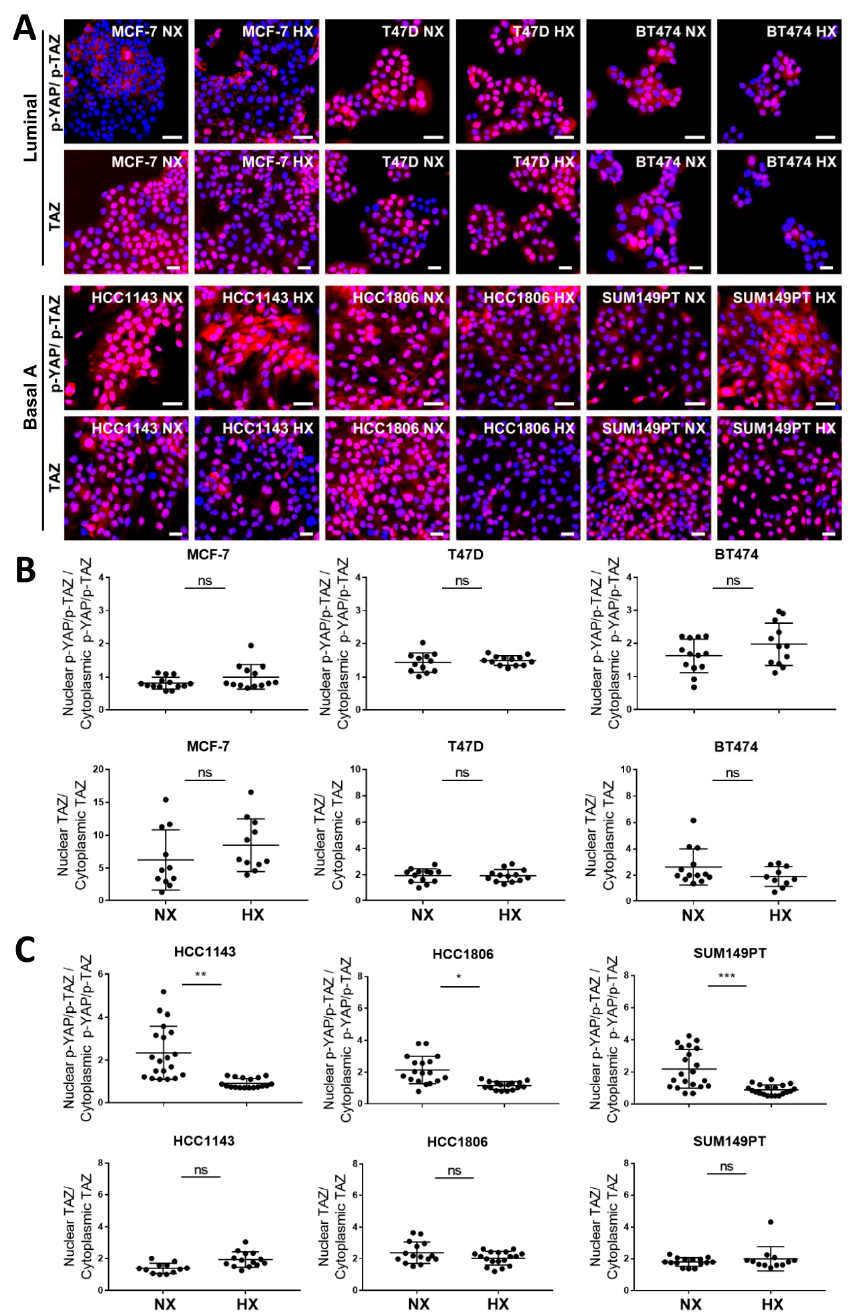
Figure 6. Localization of TAZ and phosphorylated YAP/TAZ in luminal breast cancer and basal A cells under normoxia and hypoxia. ( A ) Localization of TAZ and p-YAP/TAZ (using an Ab